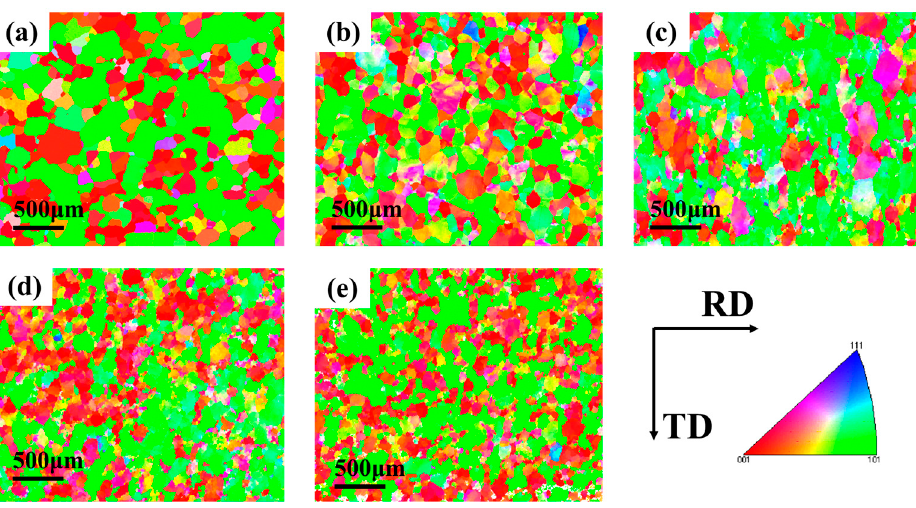
Figure 12. Reverse polar diagrams at different temperatures: ( a ) original; ( b ) 400 °C; ( c ) 425 °C; ( d ) 450 °C; ( e ) 475 °C.